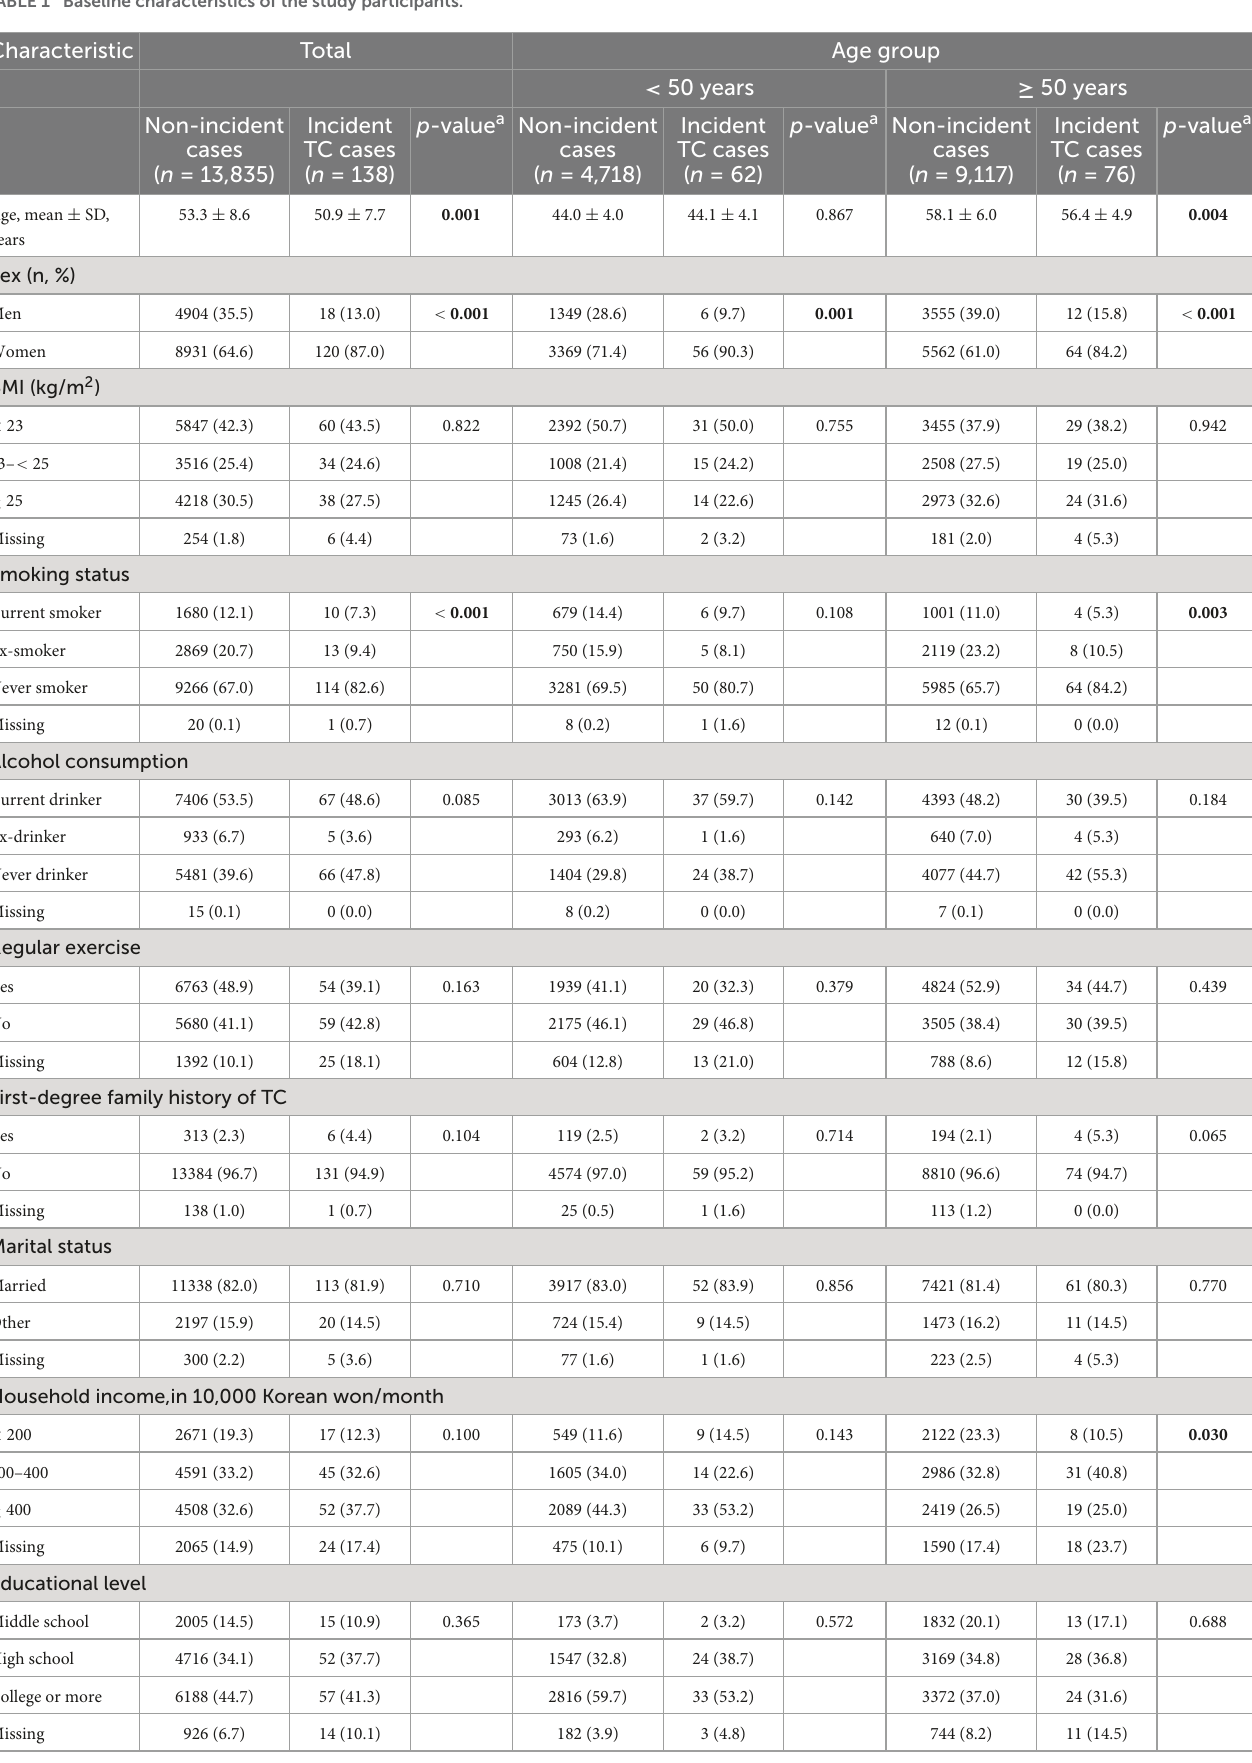
TABLE 1 Baseline characteristics of the study